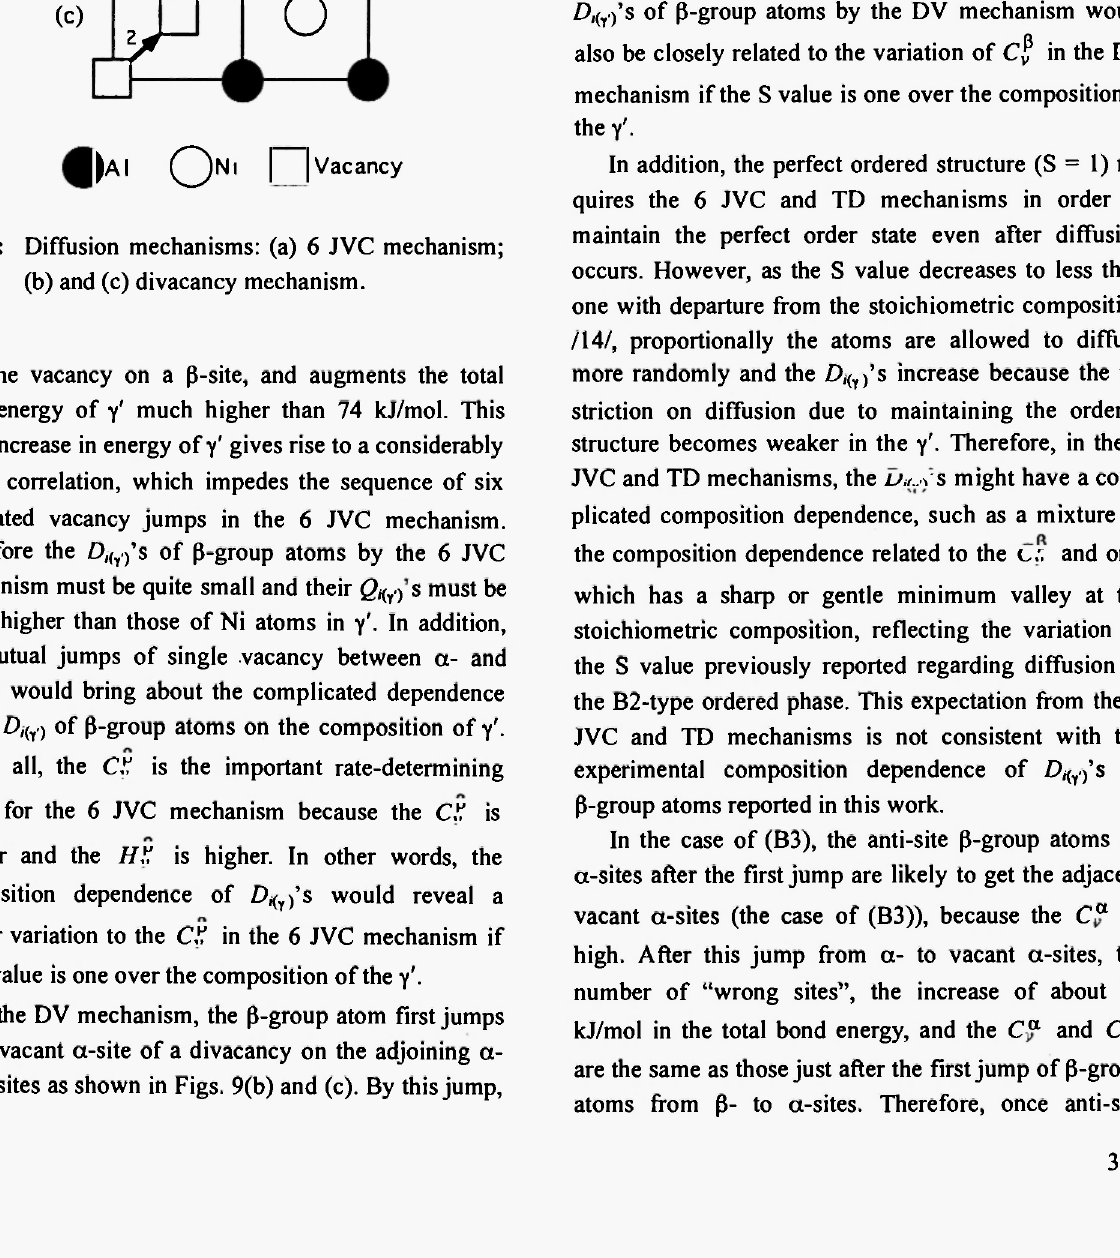
Fig. 9: Diffusion mechanisms: (a) 6 JVC mechanism; (b) and (c) divacancy